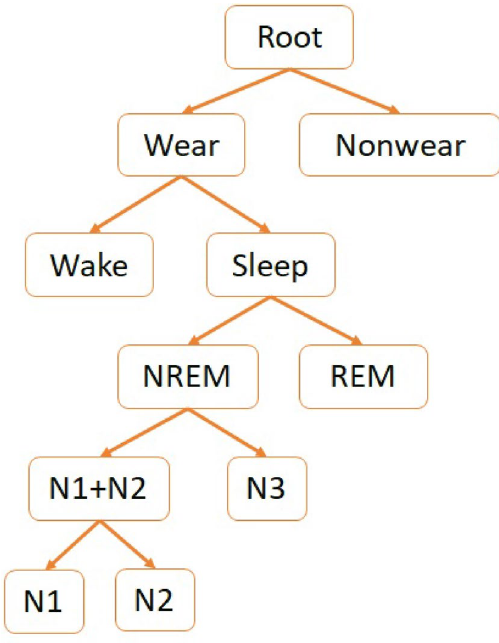
Figure 4. Hierarchy of classes used in sleep stage